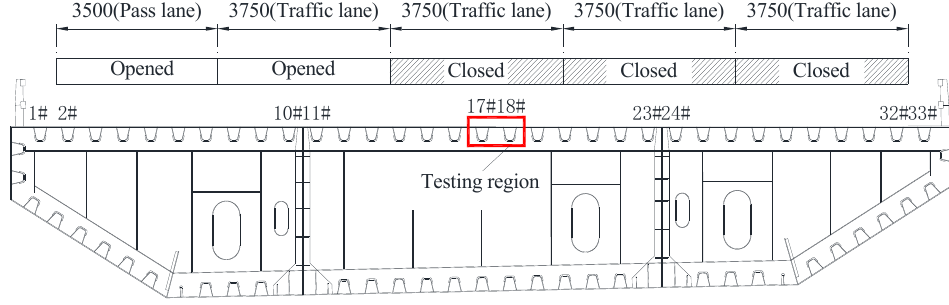
Figure 1. Structure of the steel box girder of a suspension bridge (unit: mm).